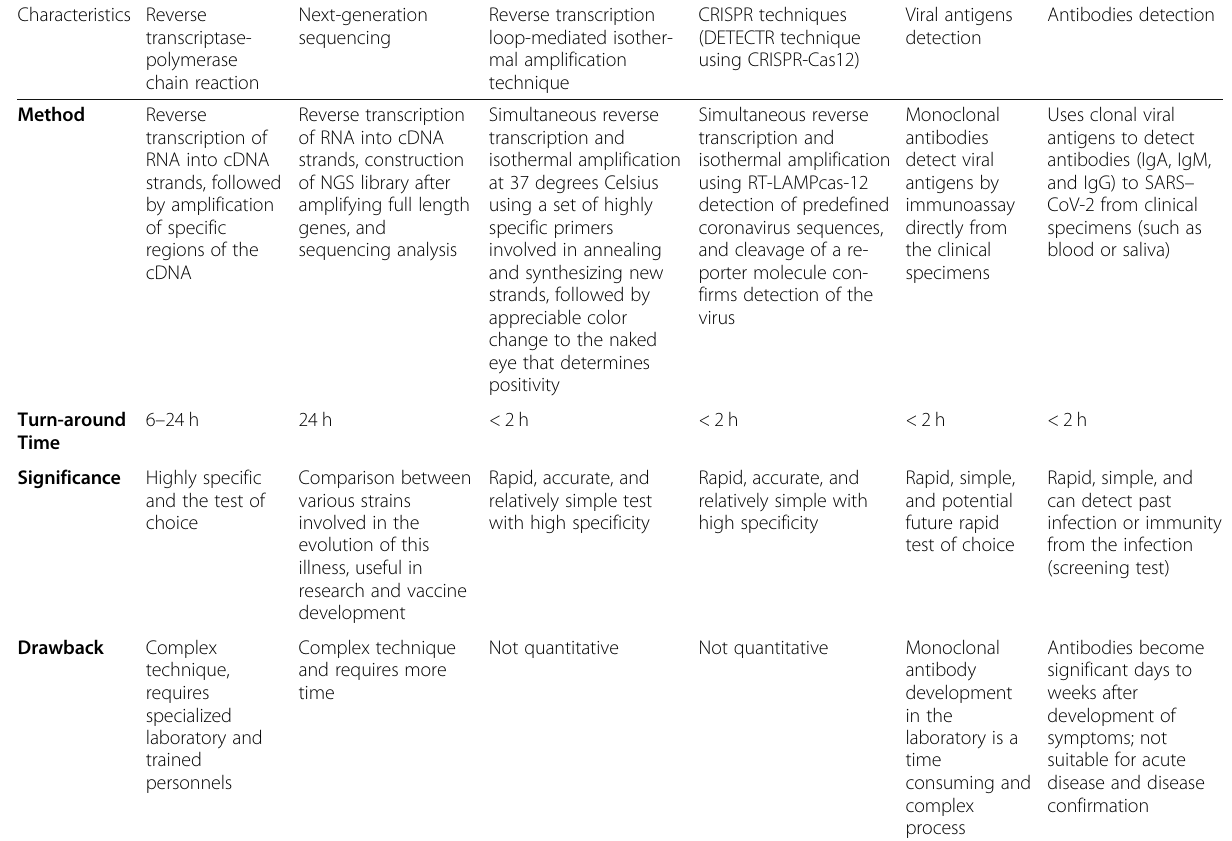
Table 3 Comparison between various diagnostic tests for COVID-19 Characteristics Reverse